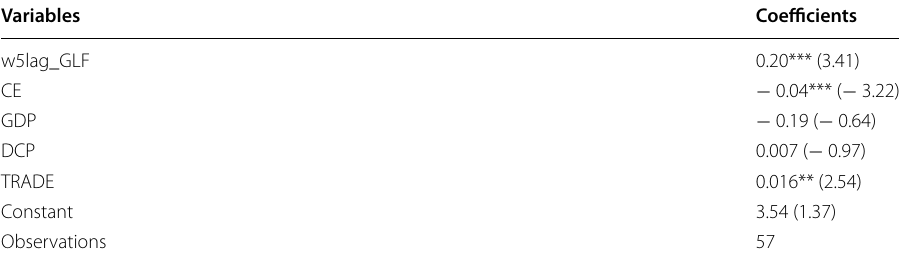
Dependent variable: lag of GLF per capita.w5lagGLF is the weighted 5 year average lag of gross loan portfolio. CE is the enforcing contracts at the country level.w5lag_GLF and GDP variables are in logarithm. Figures in brackets show t